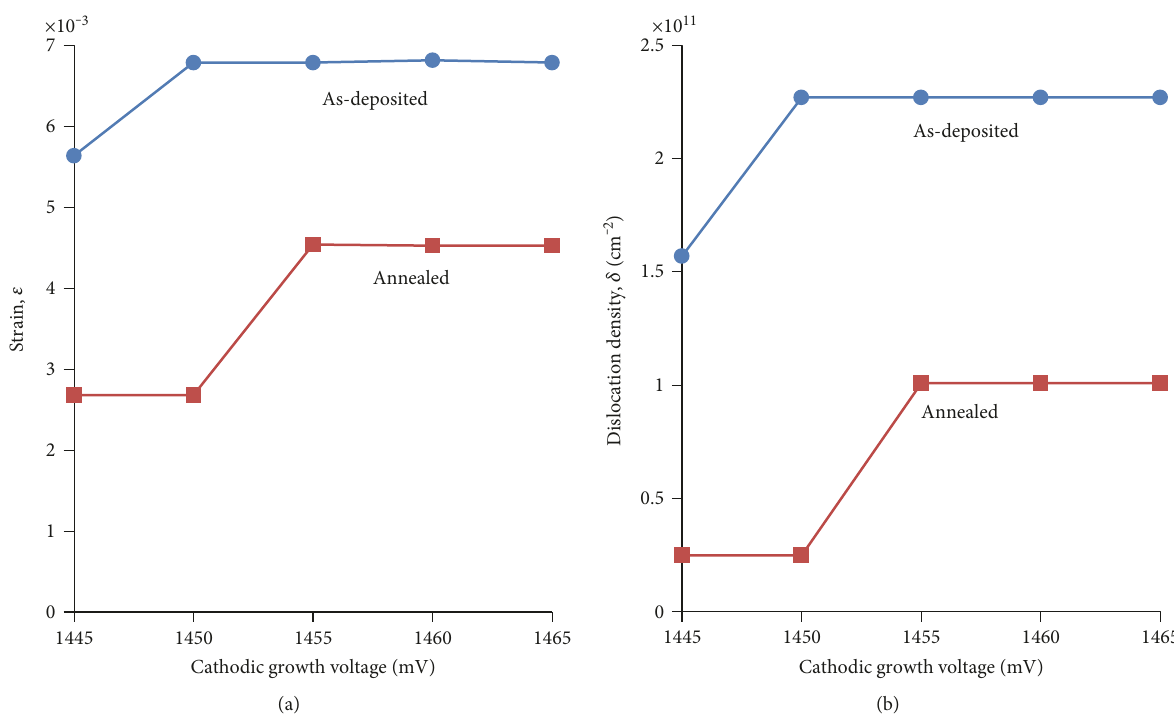
Figure 3: Variation of (a) internal strain and (b) dislocation density with growth voltage for the as-deposited and annealed CdS Table 4: PEC signals of n-type as-deposited and annealed CdS layers grown at di ff erent cathodic voltages.